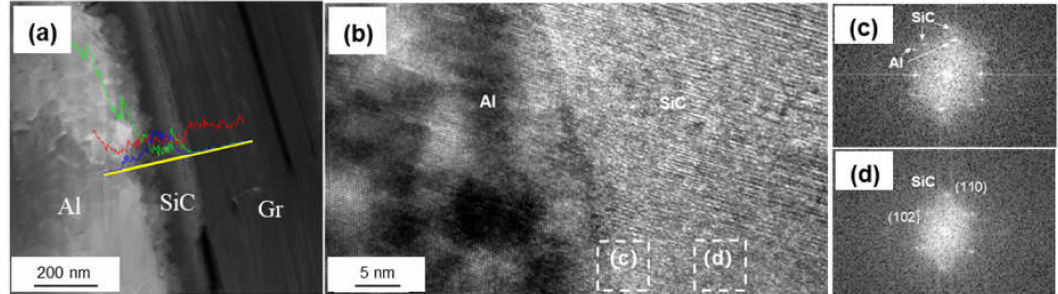
Figure 7. ( a ) Interface morphology of the Si-coated Graphite/Al prepared by FIB; ( b ) HRTEM image of SiC/Al surface; ( c , d ) FFT of ( b ).